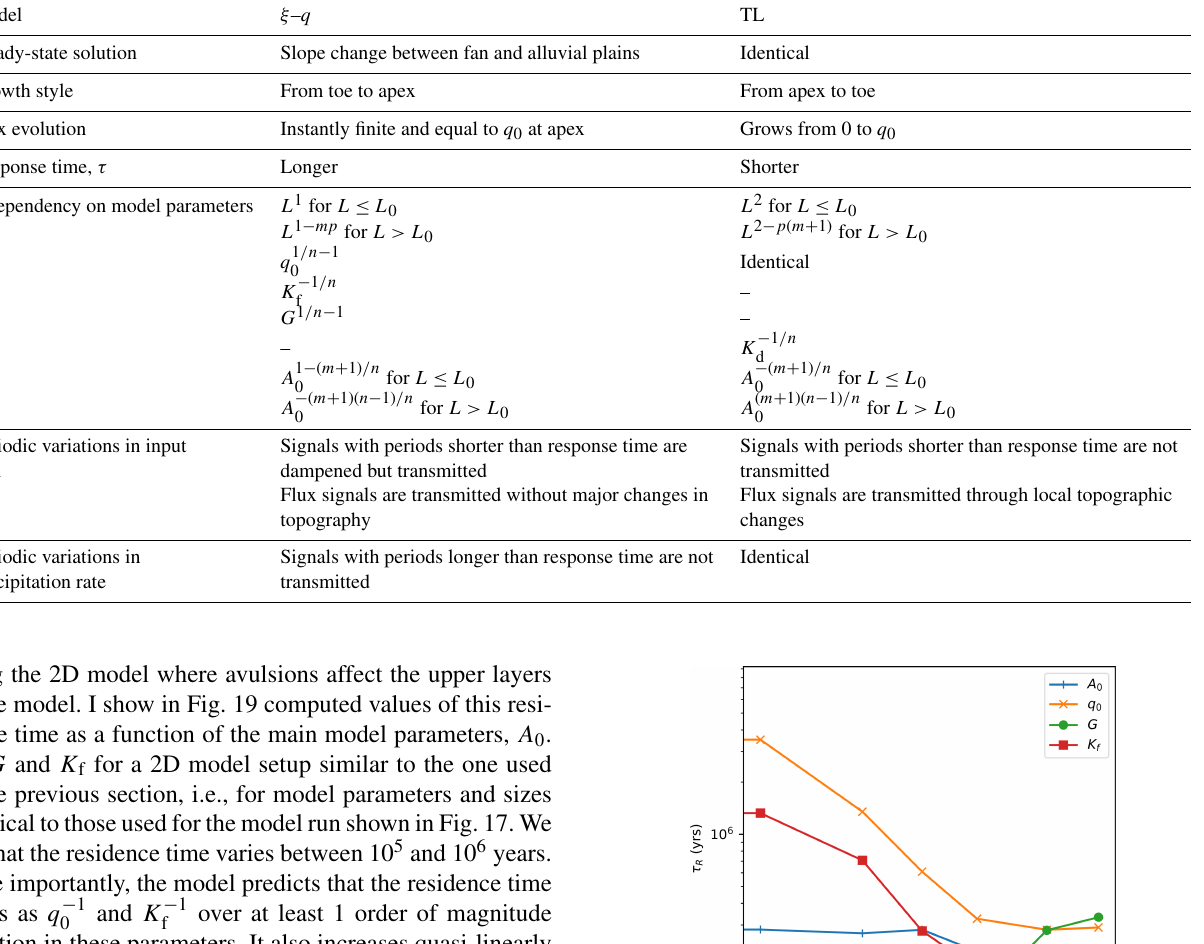
Table 1. Comparison between the two models. Model ξ – q TL Steady-state solution Slope change between fan and alluvial plains Identical Growth style